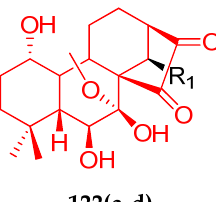
Figure 116. Structure of nitrogen mustard contain oridonin derivatives 122 ( a – d ). Table 103. In vitro cytotoxic activities of nitrogen mustard ‐ containing oridonin hybrid compounds 122 ( a – d ).